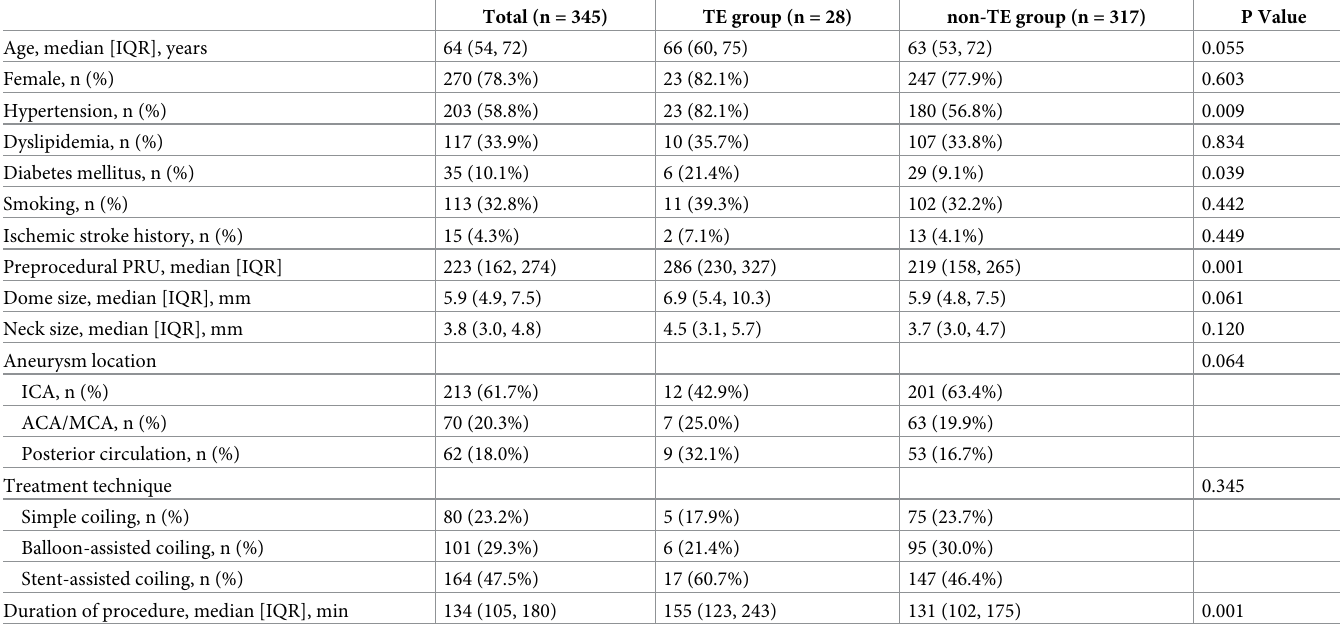
Table 1. Baseline characteristics of patients in the TE and non-TE groups.